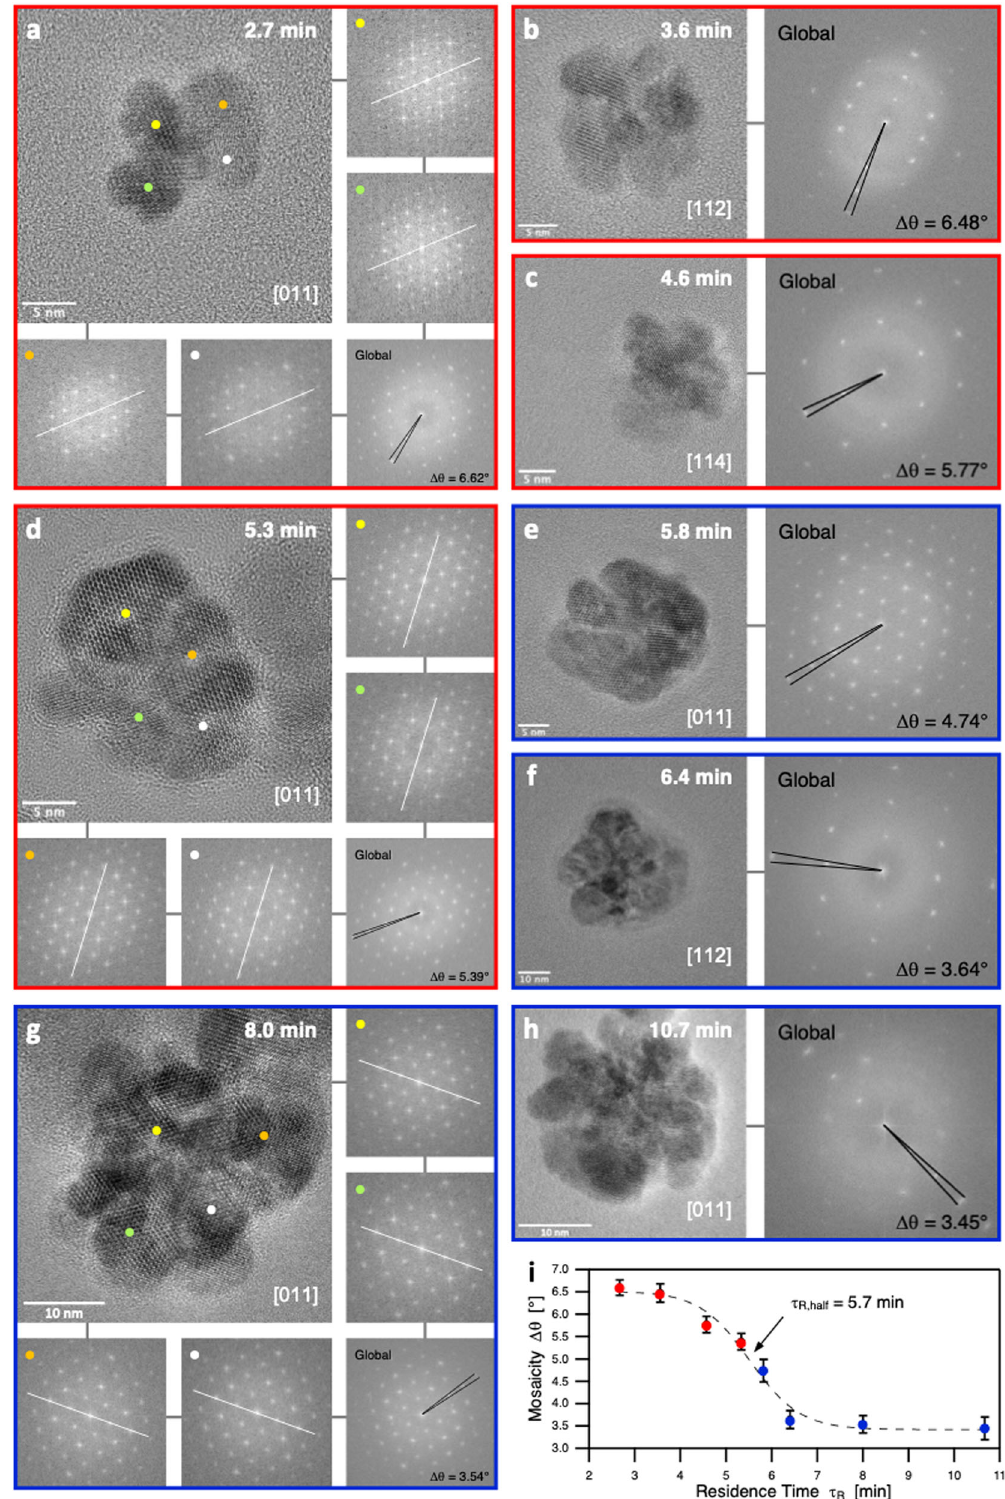
Fig. 4 Fine-structure analysis of core disorders. a – h HR-TEM micrographs of the NFs and their corresponding FFT for mosaicity measurements ( Δ θ ) during growth (red: a , b , c , d ) and aggregation (blue: e , f , g , h ) stages. i Mosaicity as a function of residence time. Error bars correspond to the standard deviation obtained from the measurements of mosaicity on 15 different isolated NFs for each residence times. White solid lines: eye-guide for an easier comparison of the local FFT; black solid lines: angular measurements of the mosaicity